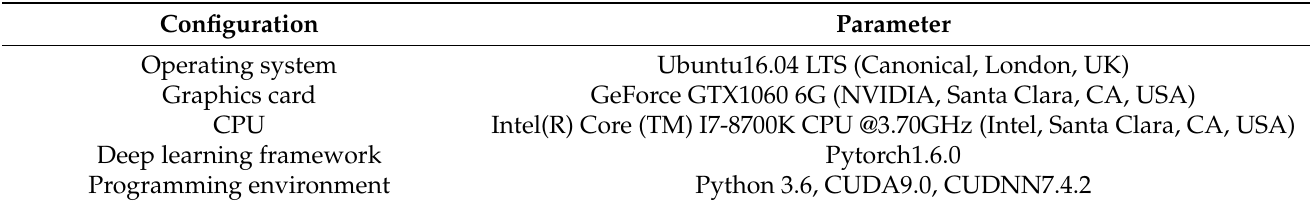
Table 2. Hardware and